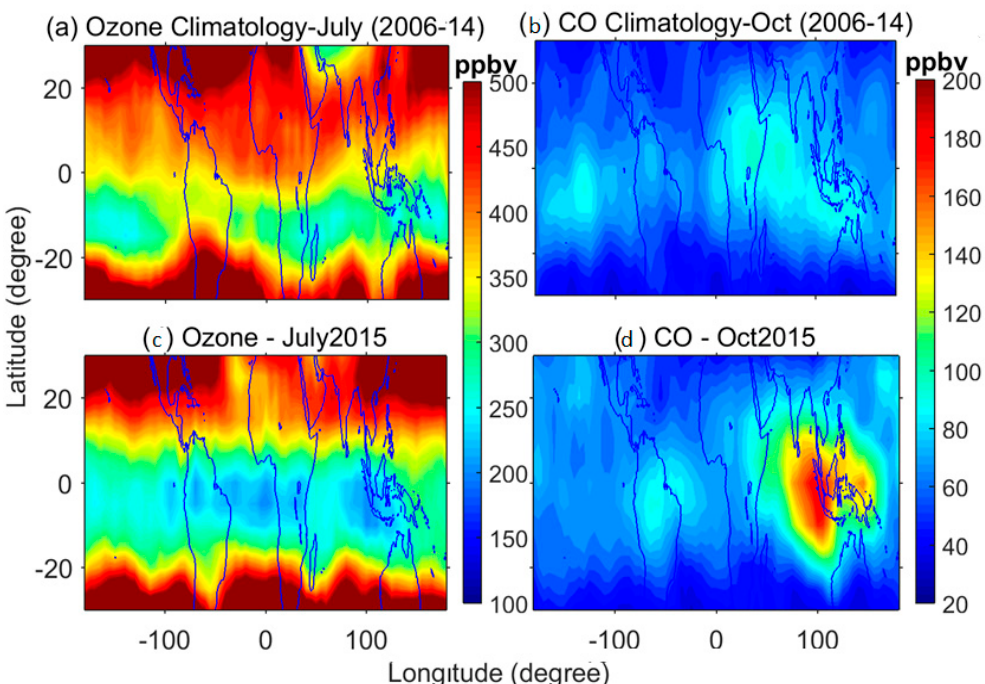
Figure 5. Background climatology (averaged 2006–2014) of ( a ) ozone mixing ratio at 82 hPa in July and ( b ) carbon monoxide at 100 hPa in October. ( c , d ) same as above but for the year 2015.